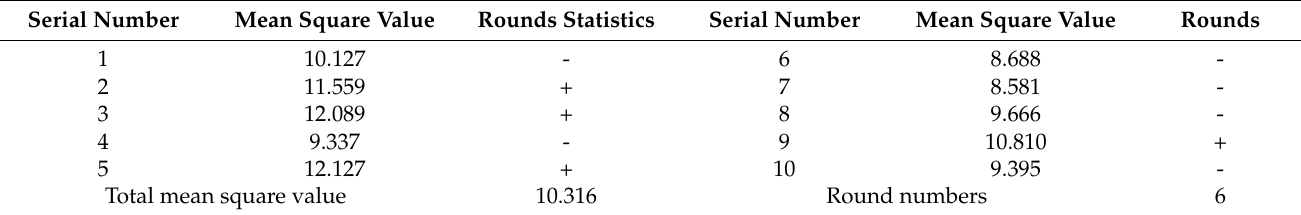
Table 3. Rounds statistics of load random term.